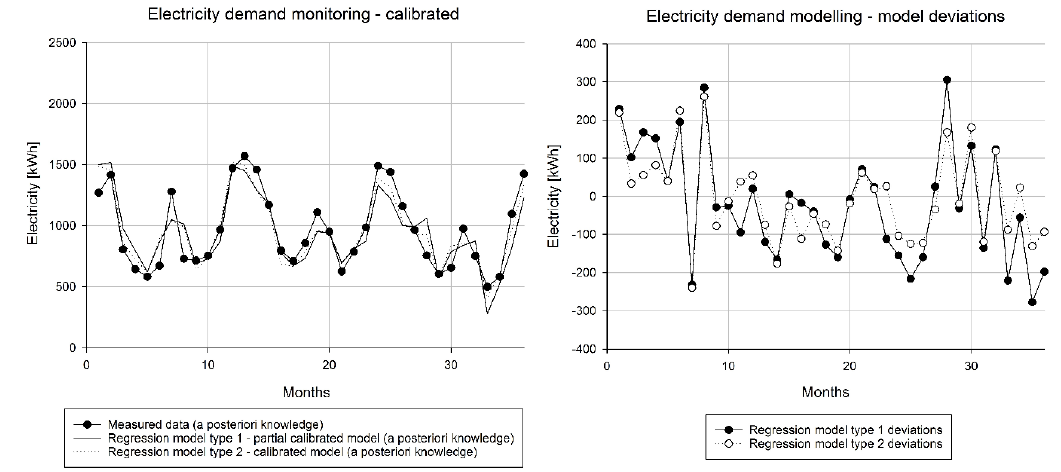
Figure 6. Electricity demand monitoring—comparison of measured data, partial calibrated regression model type 1, calibrated regression model type 2 and deviations between measured and predicted data.